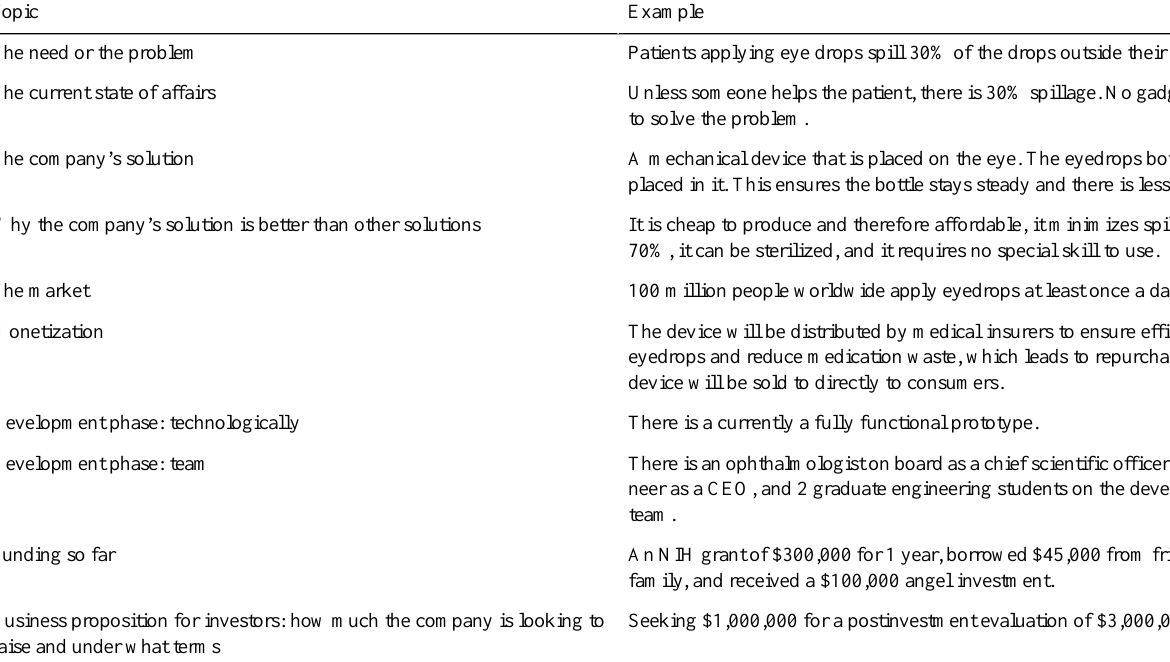
Table 1. Topics to be addressed in a business presentation (pitch) for a hypothetical product to reduce eye drop